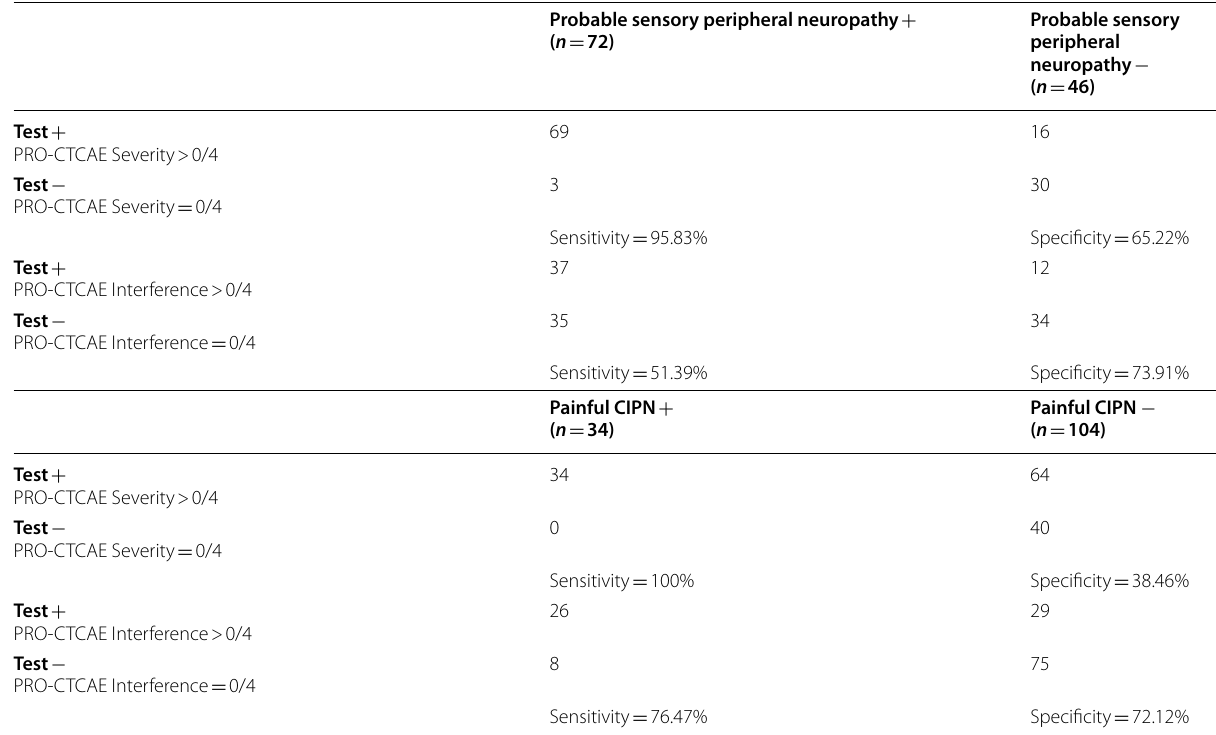
Table 3 Sensitivity and specificity of the PRO-CTCAE items to probable sensory peripheral neuropathy and painful chemotherapy- induced peripheral neuropathy (CIPN)